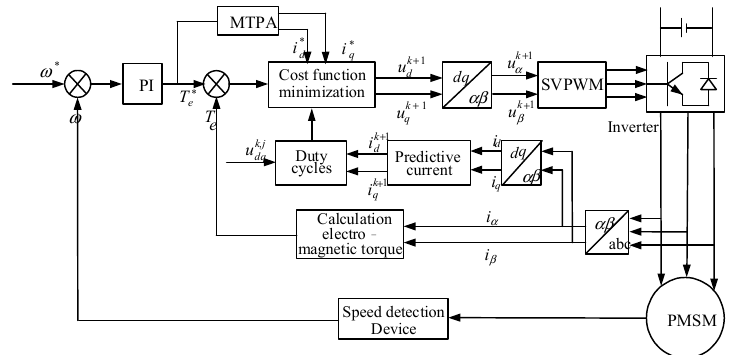
Figure 5. Block diagram of the proposed MPC.